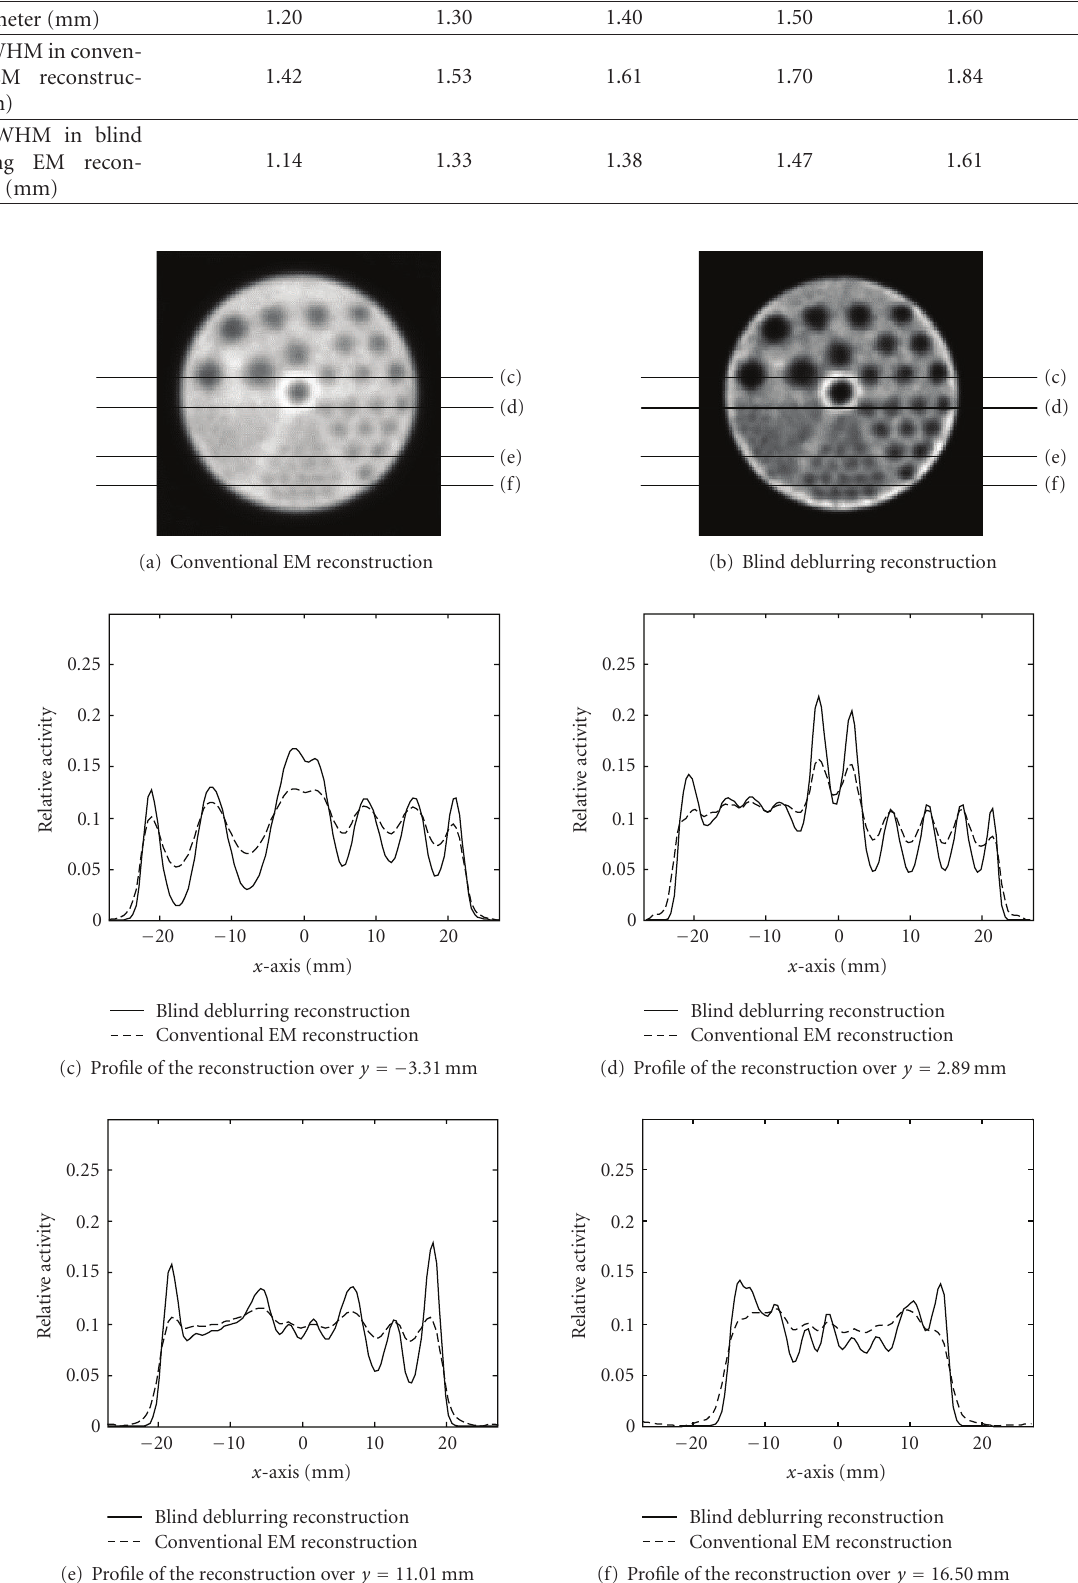
Figure 6: Slice from cold-rod phantom reconstruction. Four sets of line profiles were drawn in the same